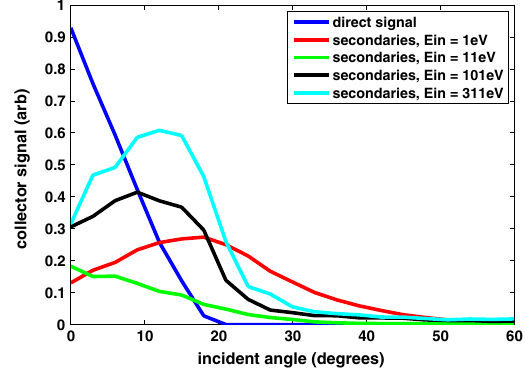
FIG. 5. Simulated collector current caused by a uniform beam of electrons incident on the thin RFA model, for various incident energies. The direct signal is determined only by the angular acceptance of the beam pipe holes (and thus does not depend on energy). The “ secondary ” signal is caused by the production of (low energy) secondary electrons in the beam pipe holes and retarding grid, and depends on the energy of the incident electrons. In general the secondary signal is highest for very low incident energies (due to the production of elastic seconda- ries), and around E in ≈ E0epk (due to the production of “ true ”